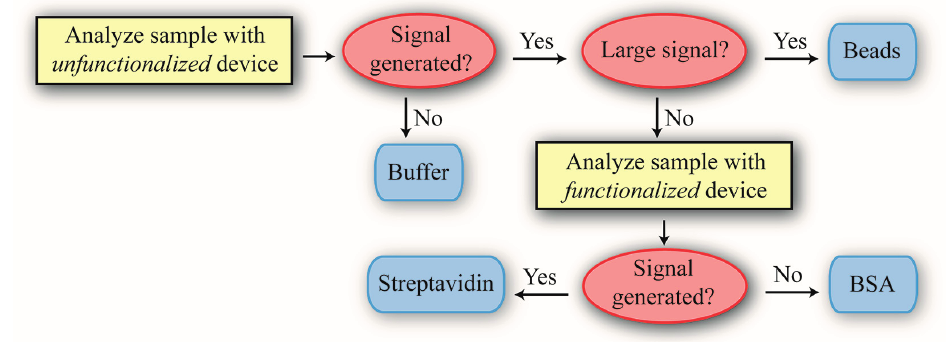
Figure 1. The decision tree used for differentiating between the four samples.